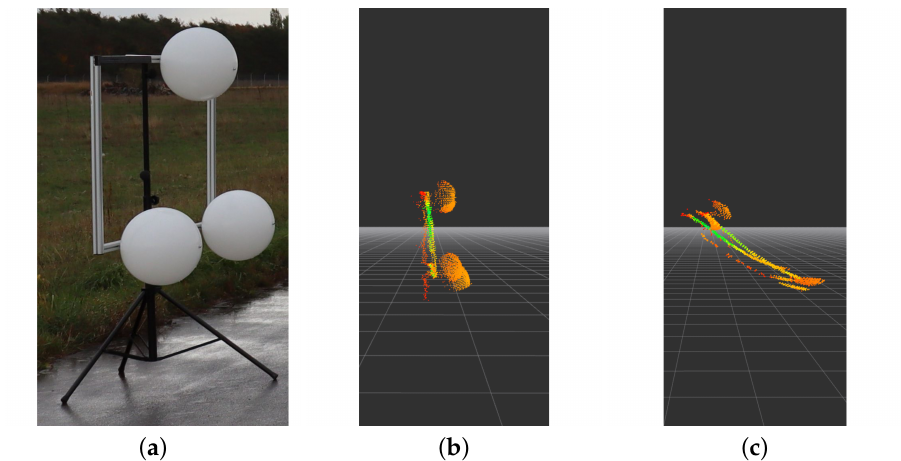
Figure 9. This figure presents the visualization of the distortion effect due to movement of the sensor at high velocities. ( a ) Picture of target. ( b ) View at 10km/h, Visualization of the measured point-cloud at 10km/h rotated so the structure can be viewed from the left side. ( c )View at 80km/h, The visualization of the measured point-cloud at 80km/h rotated so the structure can be viewed from the left side. In ( c ), the measured structure is virtually stretched over a span of